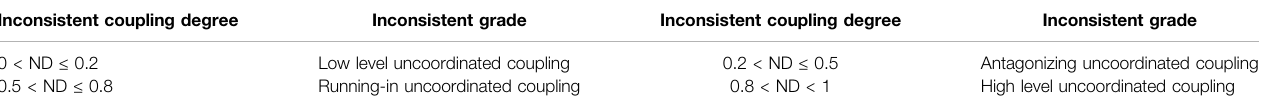
TABLE 3 | Evaluation table for uncoordinated coupling level.